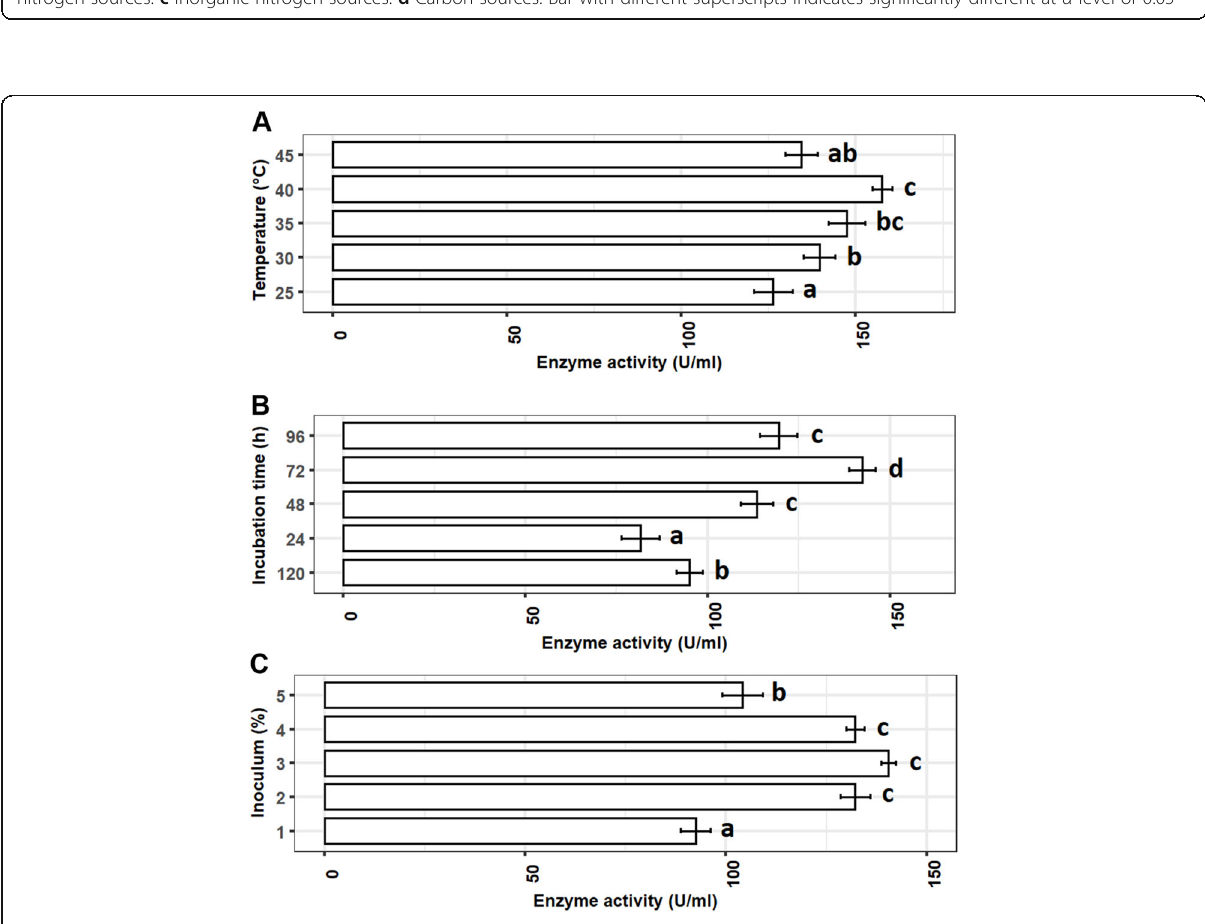
Fig. 4 Effects of different culture conditions on production of keratinase by the P. aeruginosa YK17 isolate. a Temperature (°C). b Incubation time (h). c Inoculum (%). Bar with different superscripts indicates significantly different at α level of